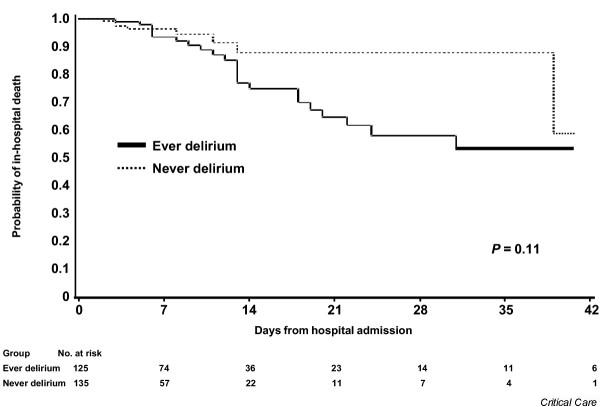
Delirium versus in-hospital mortality. This Kaplan-Meier plot shows the relationship between delirium and in-hospital mortality by classification of Ever Delirium versus Never Delirium (p = 0.11, univariate analysis).